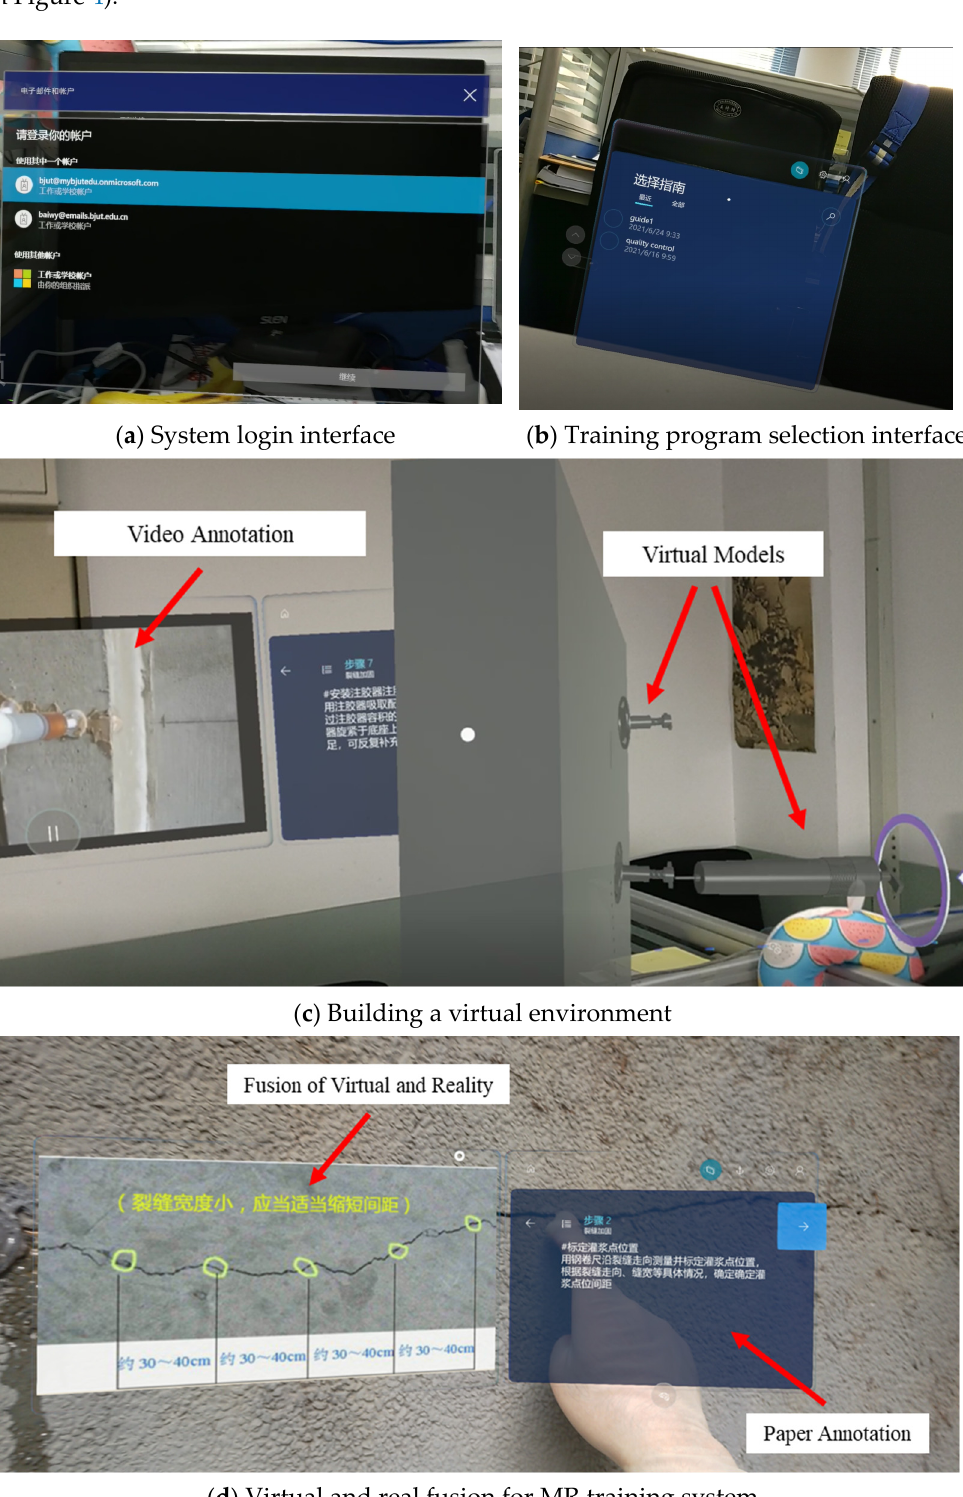
Figure 3. Parts of MR retrofitting training process.